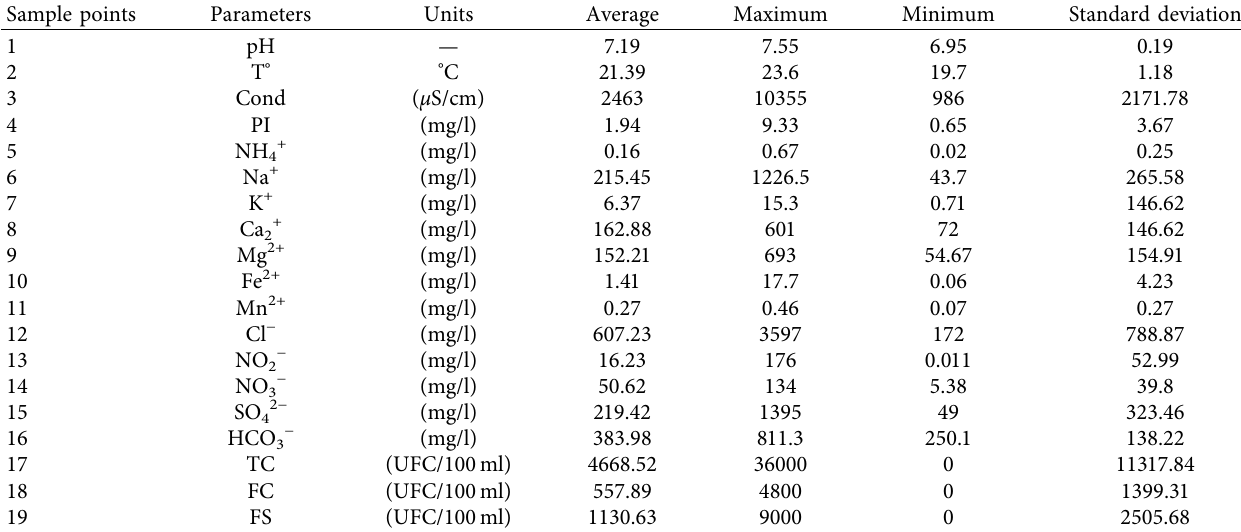
Table 1: Physicochemical and bacteriological data of the Angads groundwater in